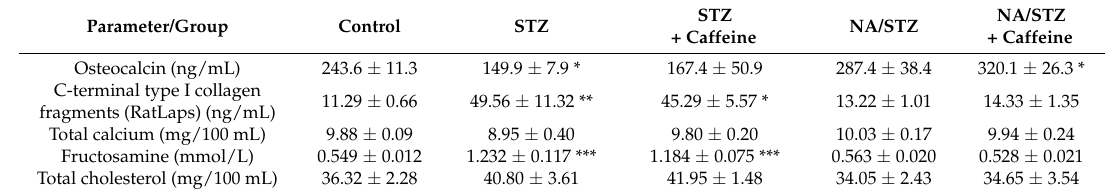
Table 1. Effect of caffeine administered orally (20 mg/kg daily for four weeks) on the serum bone turnover markers and other biochemical parameters in rats treated with streptozotocin (STZ) or nicotinamide and streptozotocin (NA/STZ). Parameter/Group